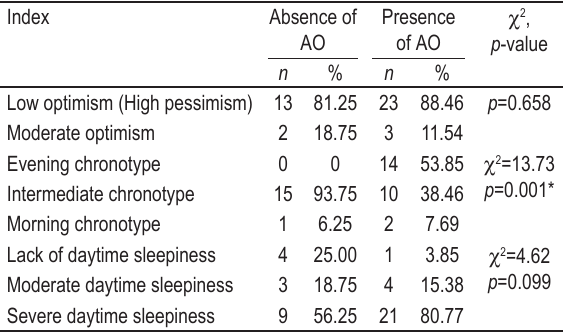
TABLE 3. Frequency of abdominal obesity (AO) registration according to criteria of metabolic syndrome in patients with arterial hypertension depending on dispositional optimism, chronotype, and level of daytime